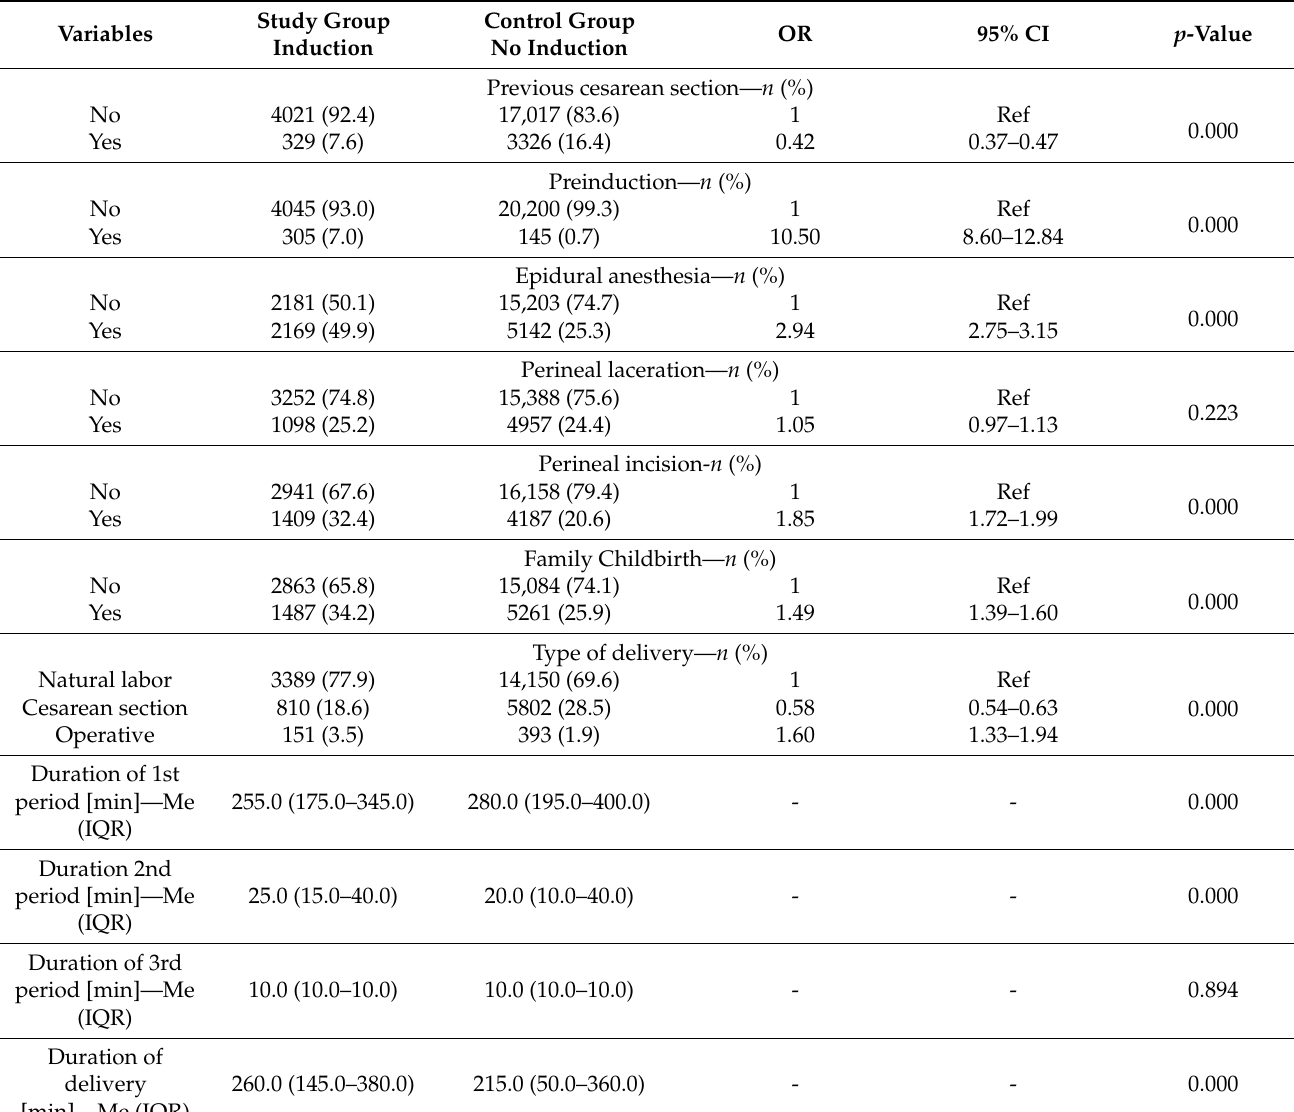
Table 3. Selected variables and induction of